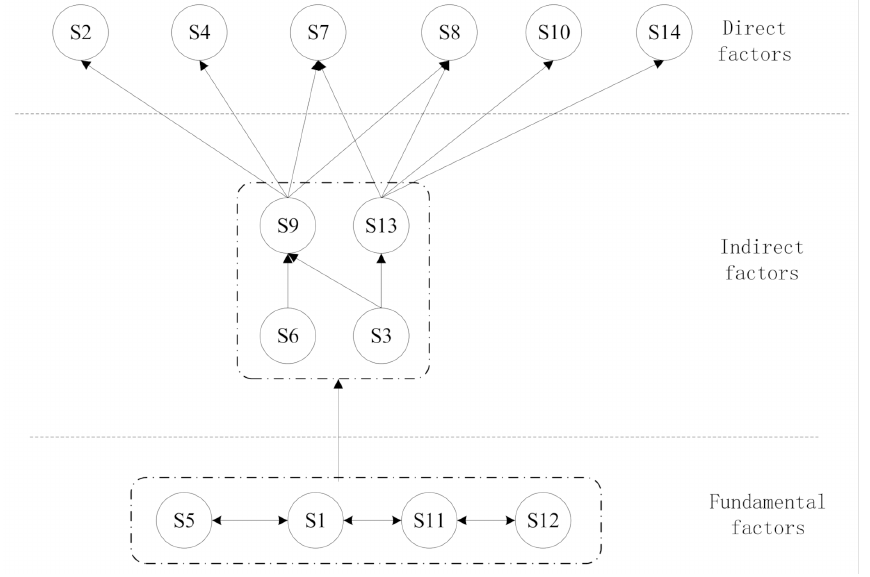
Figure 5. Multi-layer hierarchical diagram of influencing